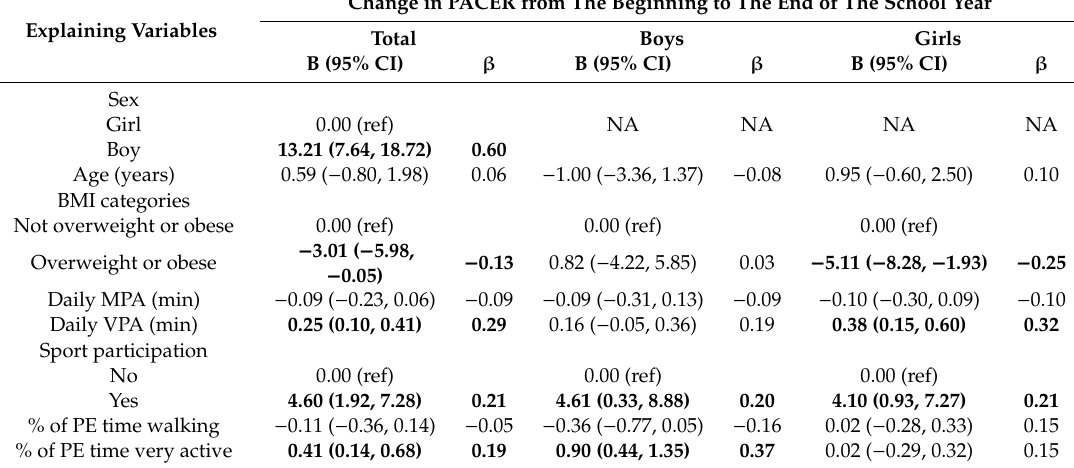
Table 3. Linear regression to explain the change in Progressive Aerobic Cardiovascular Endurance Run (PACER) laps from the beginning to the end of the school